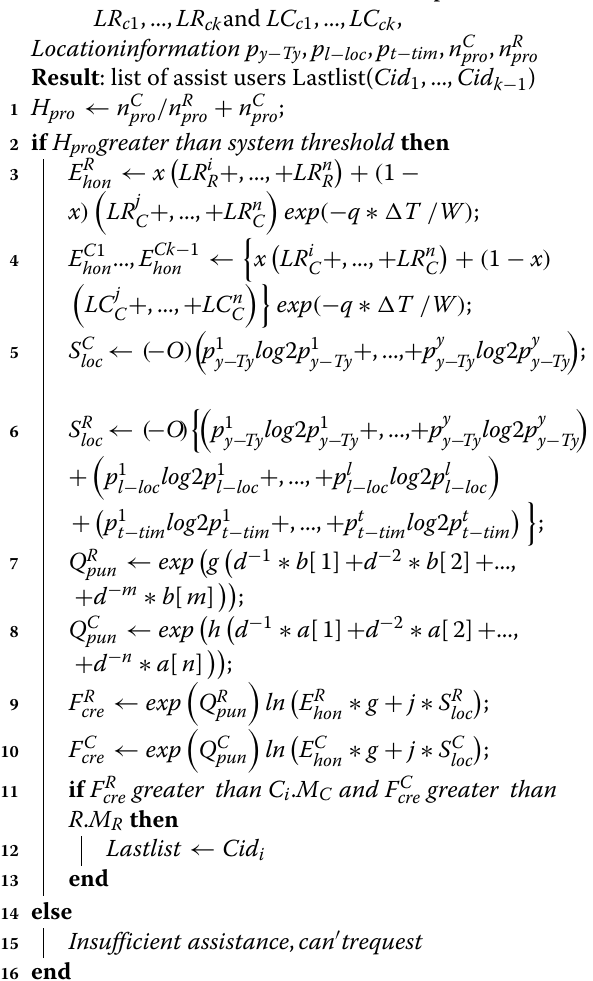
Algorithm 2: Calculate credit function Data : requestor’s history scores LR r and LC r ,historical scores for k − 1 helpers LR c 1 , ..., LR ck and LC c 1 , ..., LC ck ,